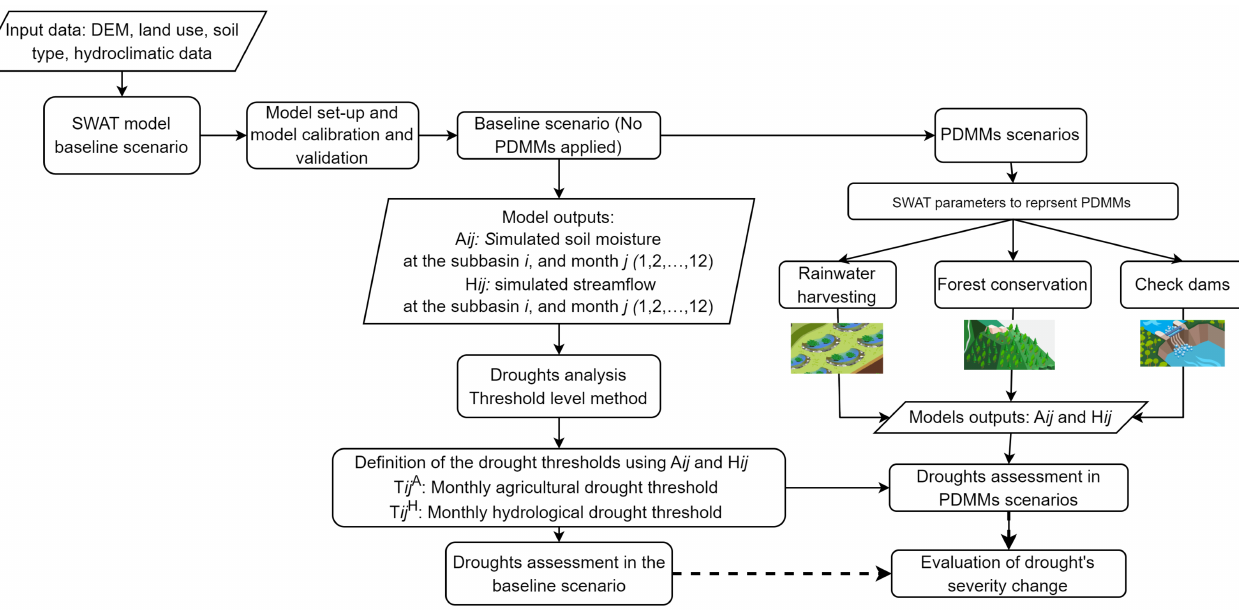
Figure 1. Flowchart of the